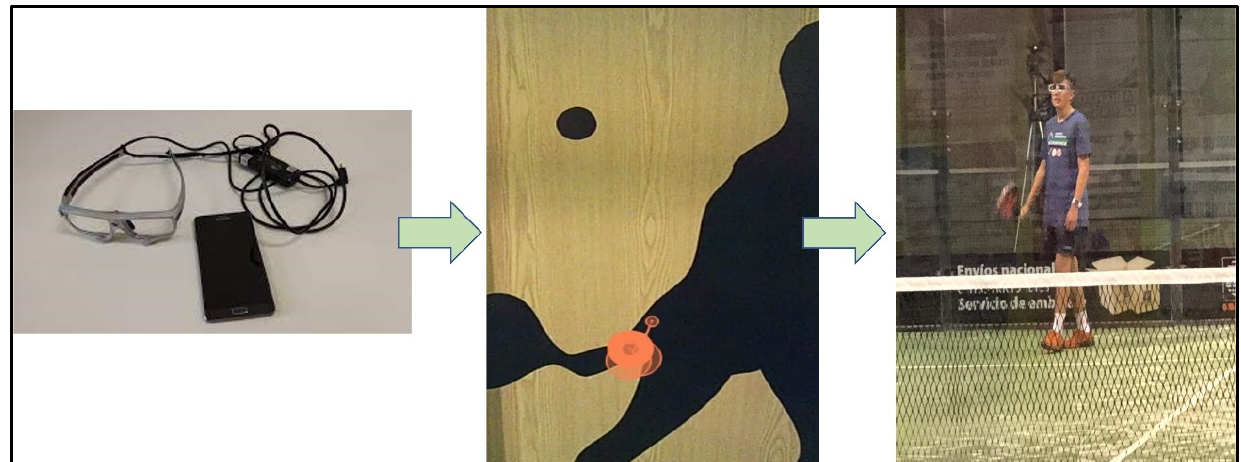
Figure 1. The SMI ETG 2w eye tracker used in this study: ( a ) with a customised Samsung Galaxy S4 smart recorder (left), ( b ) during the calibration process onto a wall sticker padel player (centre), and ( c ) already working to capture a padel player’s natural gaze behaviour in real time (right).